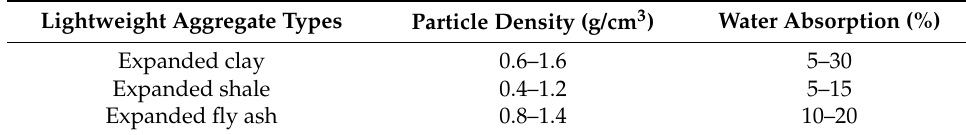
Table 14. Particle density and water absorption of three main synthetic LWAs [2].